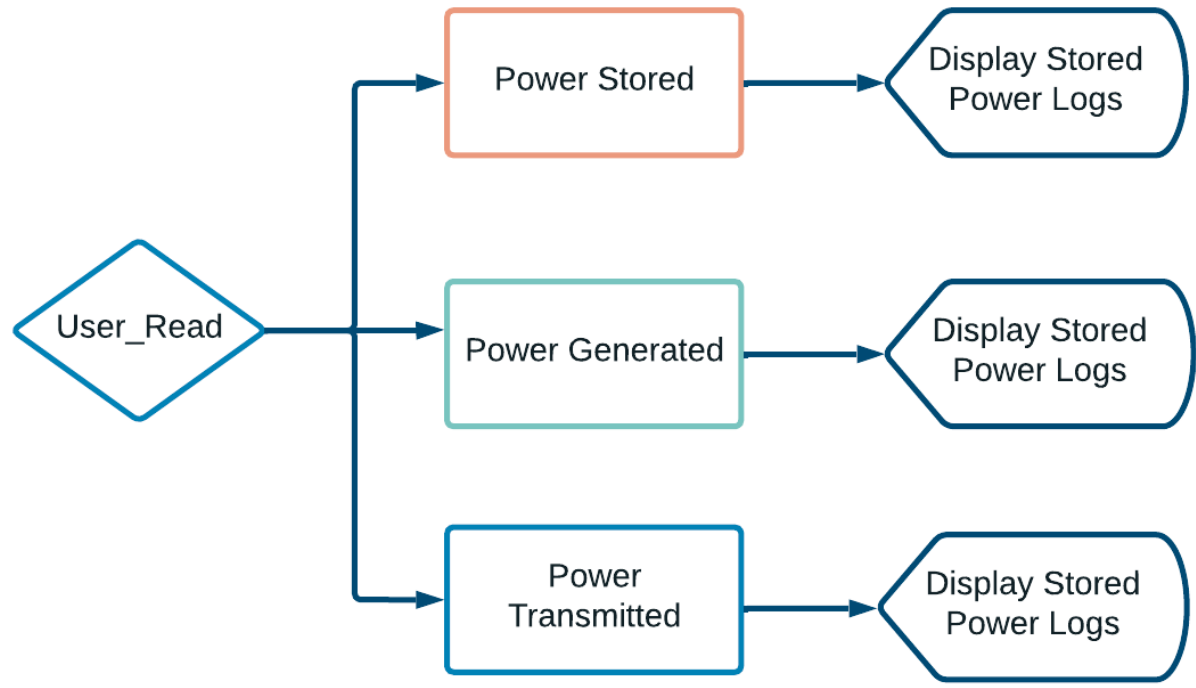
Figure 3. Data Access of the Generated Power.